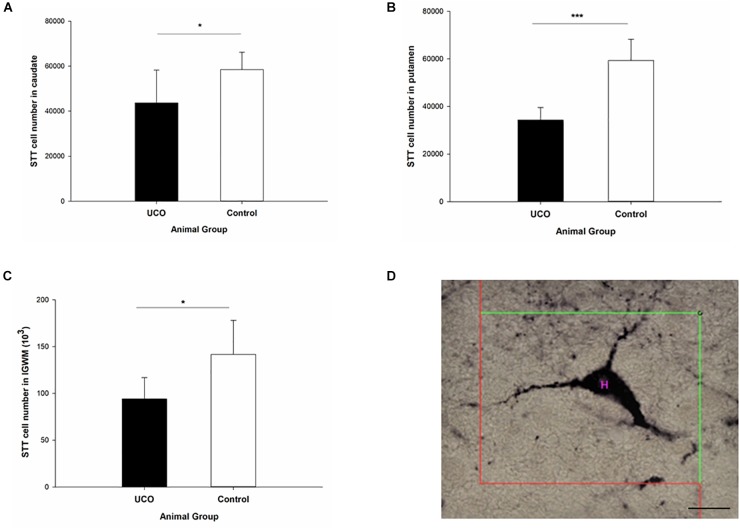
The effect of umbilical cord occlusion (UCO) on the total number of somatostatin (STT) interneurons in block B regions of interest: (A) caudate; (B) putamen; (C) intragyral white matter (IGWM) (∗p < 0.05, ∗∗∗p < 0.001). (D) Illustration of counting the number of STT interneuron inside the unbiased counting frame on the light microscope connected to newCAST software with a 63X oil immersion lens. Mean ± SD. Scale bar = 15 μm.